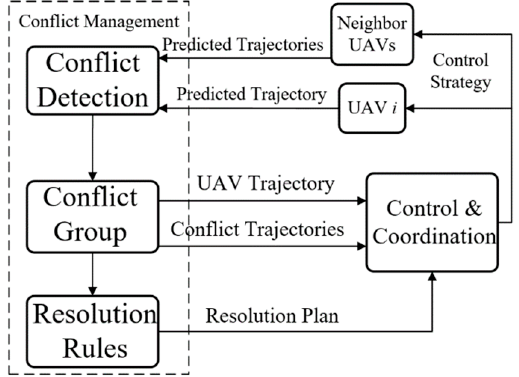
Figure 1. Scheme of solution for conflict resolution problem.